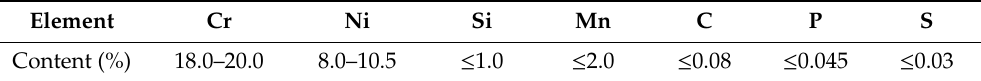
Table 1. Chemical composition of 304 stainless steel (Wt. %).